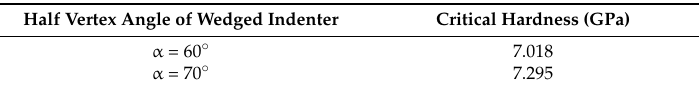
Table 1. Critical hardness of wedged nanoindentations